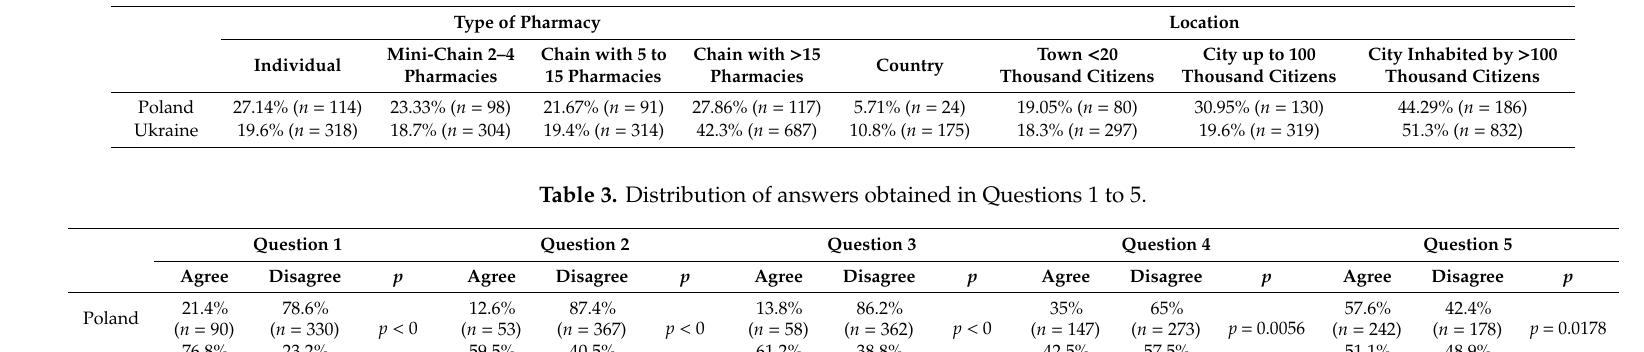
Table 2. The distribution of socio-demographic results.